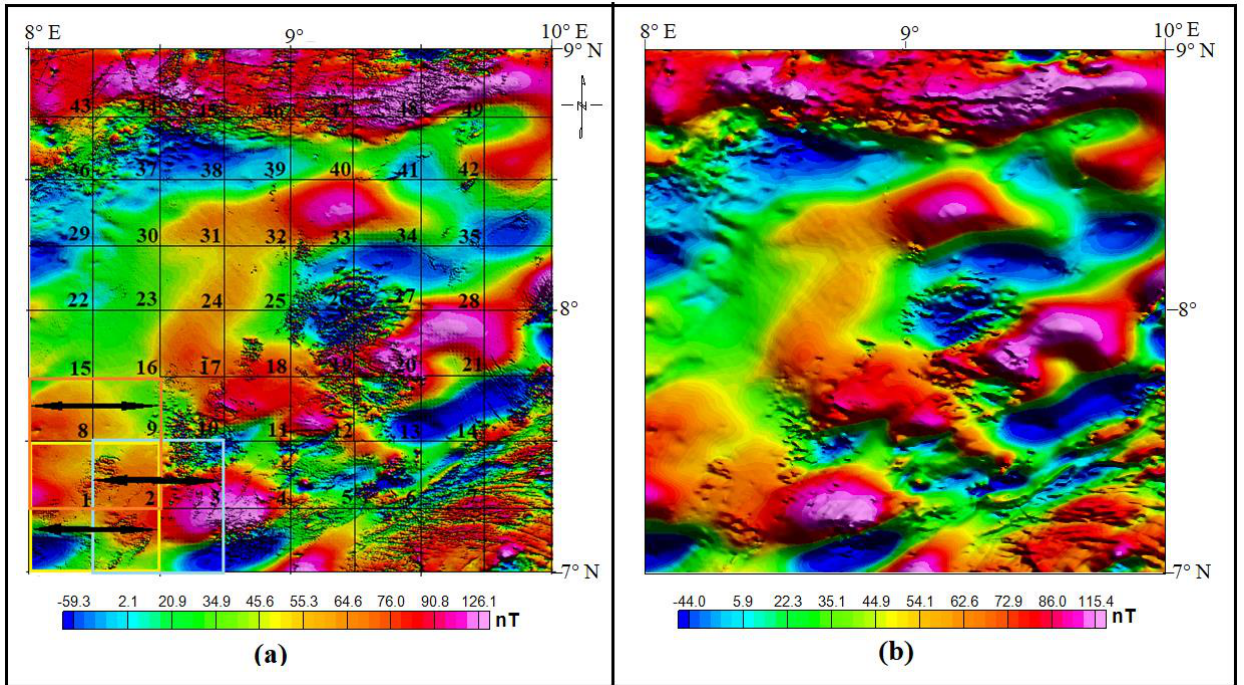
Figure 5. ( a ) The TMI map showing the division of the spectral blocks into 55 km × 55 km with 50% overlap. The block’s centers are numbered from 1–49. The boundaries of blocks 1, 2, and 8 are shown by yellow, blue, and orange lines, respectively. ( b ) The upward-continued TMI map.